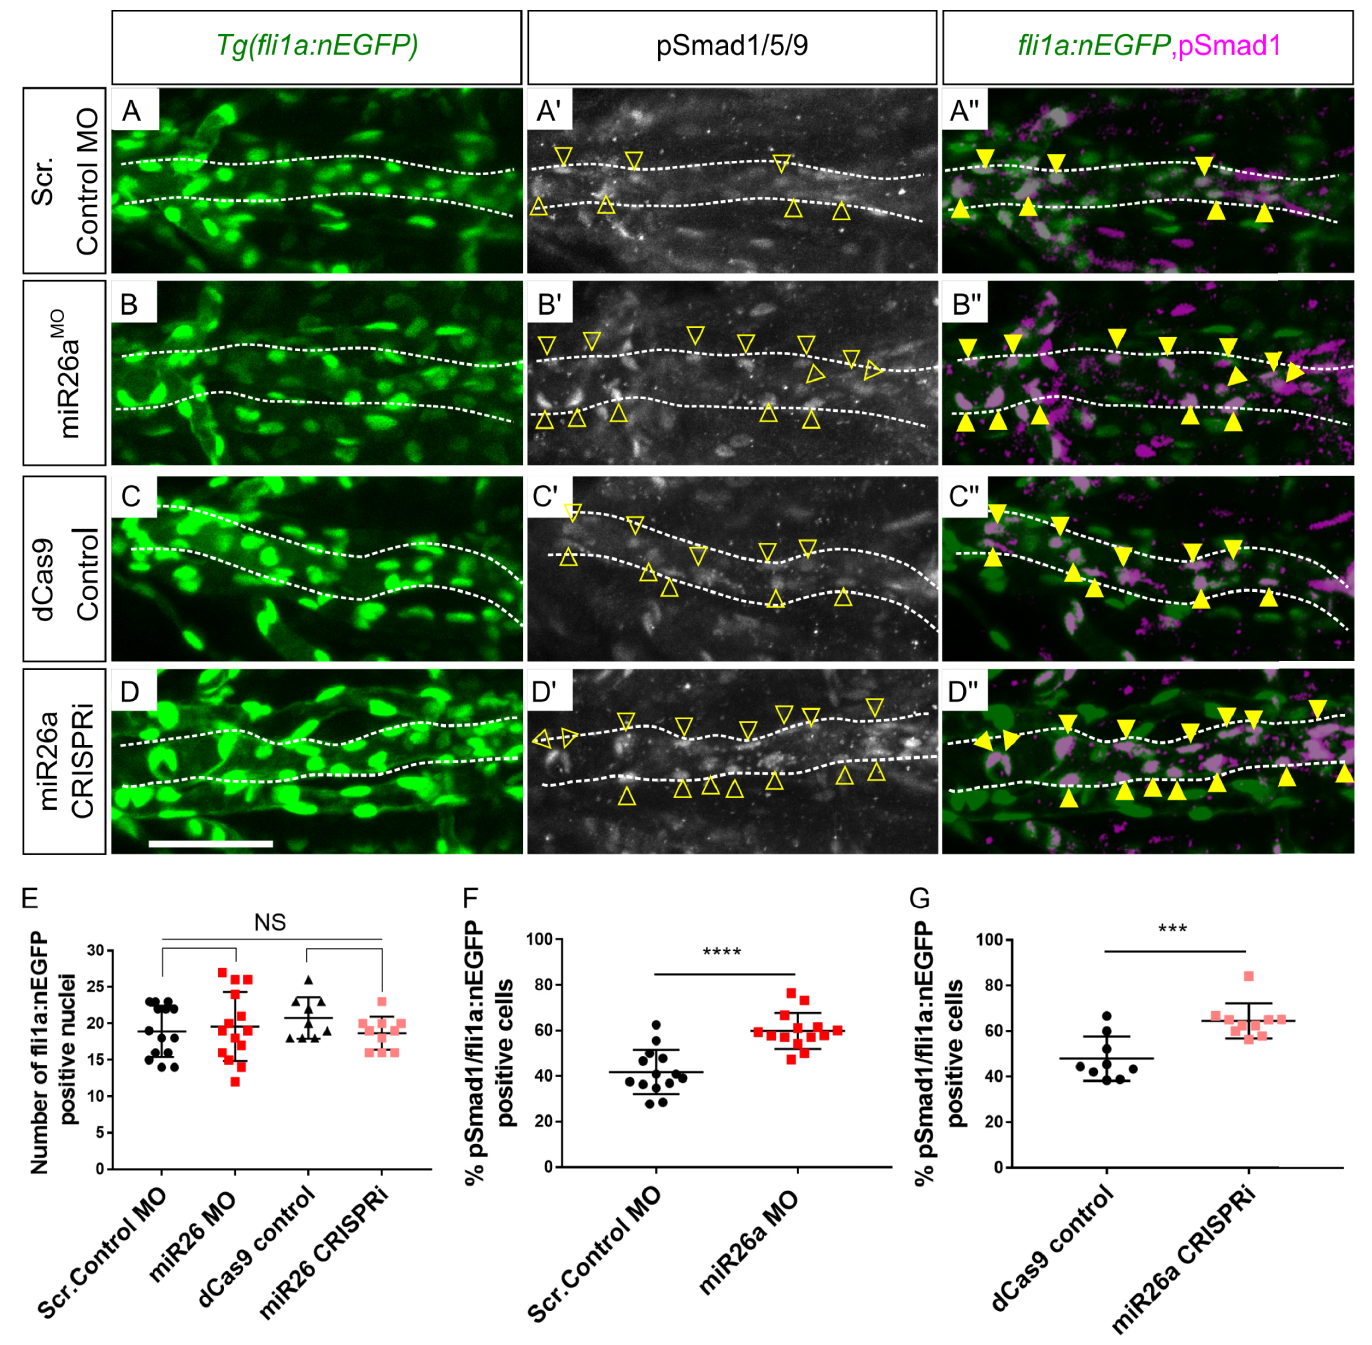
Fig 3. miR26a knockdown embryos have increased endothelial pSmad1. A-D) Ventral view confocal projections of the 4 dpf ventral aorta (dotted outline). Endothelial nuclei ( fli1a : nEGFP ; A-D, arrowheads) and pSmad1/5/9 (pSmad1,white A’- D’) and overlay (magenta, A”- D”) in 4 dpf Scr. Control (A), miR26a MO (B), dCas9 control (C) and miR26a CRISPRi (D) embryos. Yellow arrowheads indicate double positive pSmad1 + fli1a : nEGFP nuclei in the ventral aorta. E) Quantification of total number of fli1a : nEGFP nuclei in the ventral aorta. F-G) Quantification of the percentage of double pSmad1; fli1a : nEGFP positive nuclei in miR26a morphants (F) and miR26a CRISPRi (G) embryos. N = 3 experiments. Total embryos are as follows: Scr. Control MO n = 14, miR26a MO n = 14, dCas9 control n = 9 and miR26a CRISPRi n = 10. Student’s two-tailed t-test, p ��� < 0.0001 and p ���� < 0.00001 as compared to WT, error bars = SD. Scale bar: represents 50 μ m.